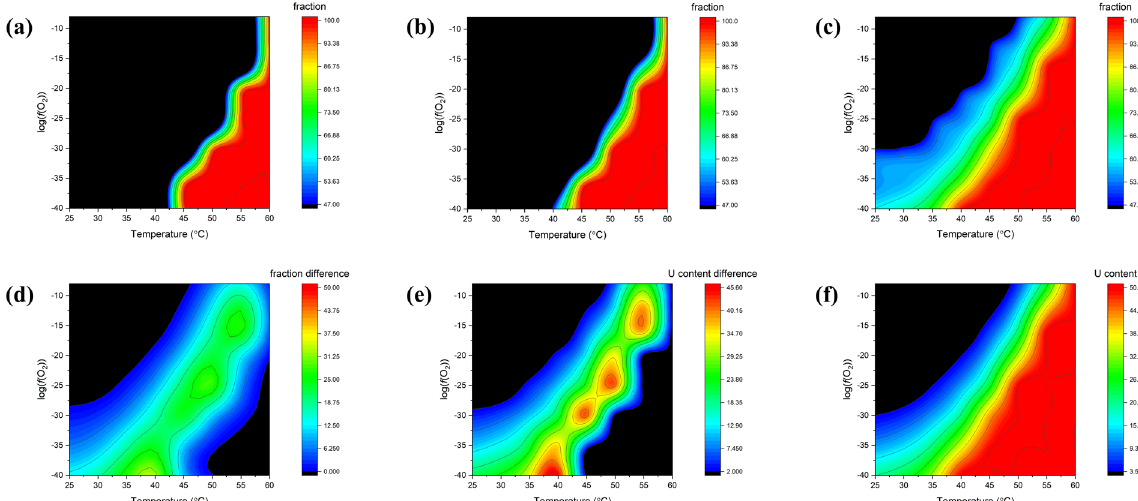
Fig. 9 The stability fi eld and U content of uranothorite. a The phase fraction of cof fi nite in model 1 where no uranothorite is allowed for form. b The phase fraction of uranothorite in model 2 where an ideal mixing model is used. c The phase fraction of uranothorite in model 3 where a subregular solid solution model (Eq. 3) is used. d The difference in phase fraction of uranothorite obtained from models 3 and 2. e The difference in U content in uranothorite phase obtained from models 3 and 2. f The distribution of U content in uranothorite phase calculated from model 3. Noted that the distributions of fraction and U content have been curve-smoothed, and the raw data can be found in Supplementary Table